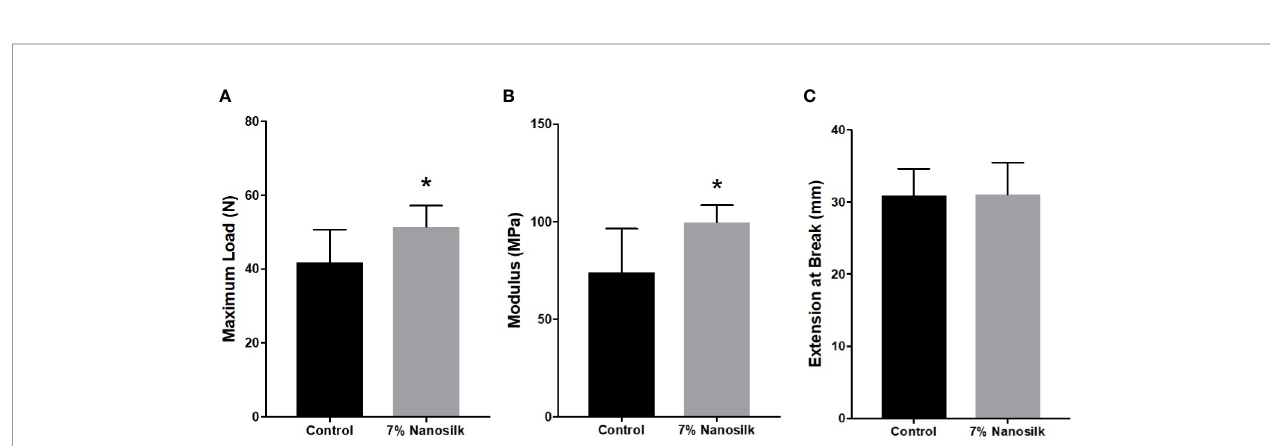
FIGURE 7 | Biomechanical properties of human diabetic skin. Human skin samples were treated with 10 ul of either PBS (control, n = 8) solution or 7% Nanosilk solution (n = 8). Nanosilk showed improved biomechanical properties with increased (A) maximum load and (B) modulus, with no change in (C) extension at point of breaking. *p < 0.05.